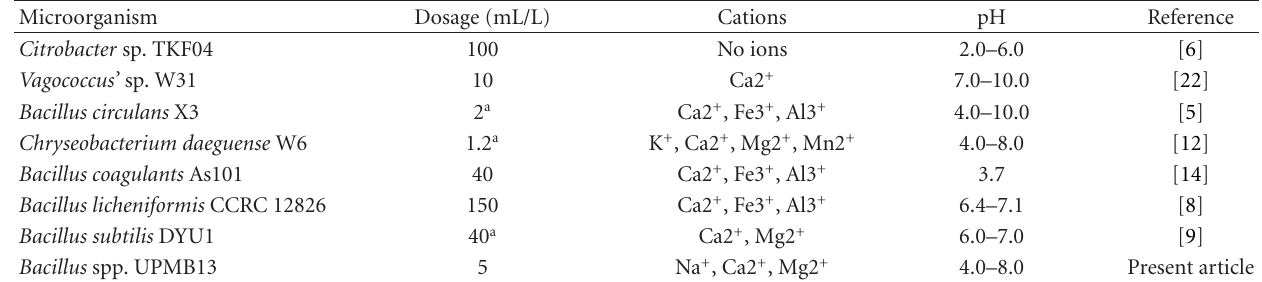
Table 5: Bioflocculant dosage, cation dependence and pH tolerance of di ff erent bioflocculant-producing microorganisms. Microorganism